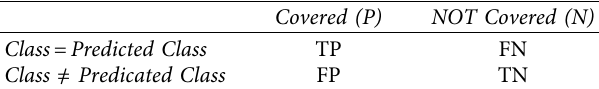
Table 4: Matrix defining TP, FN, FP, and TN in the context of classification